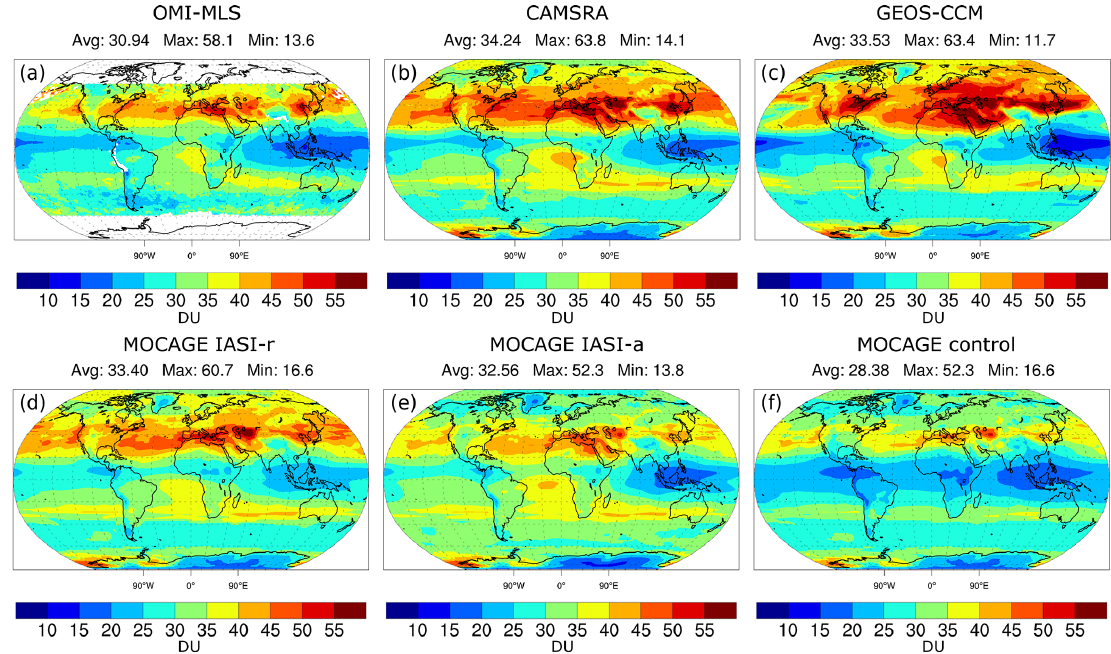
Figure 6. Tropospheric ozone column averaged over June–July–August 2010 from OMI-MLS retrievals (a) , CAMSRA reanalysis (b) , GEOS-CCM simulation (c) , IASI-r reanalysis (d) , IASI-a reanalysis (e) , and the MOCAGE control simulation (f) . Mean, minimum, and maximum values of ozone (in DU) are depicted over each plot.